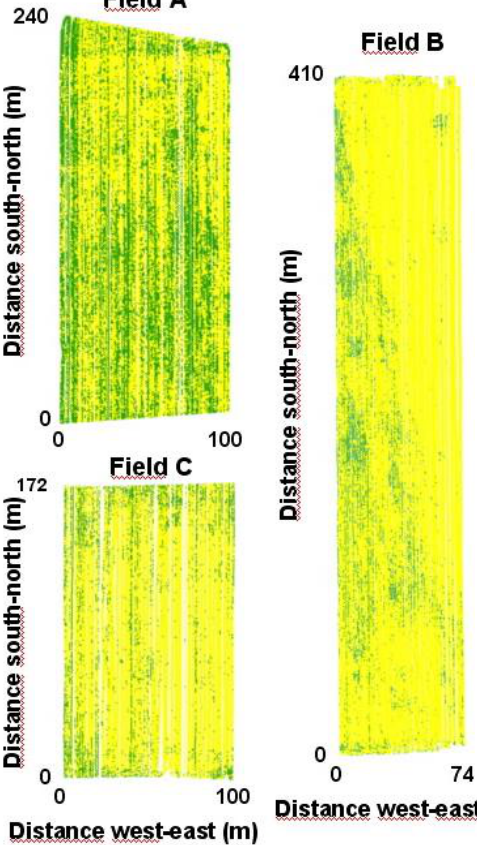
Figure 1. Detailed maps based upon weed sensing in all crop rows (sensors separated 0.75 m). Green points indicate presence of weeds, i.e. , weed coverage  15%. Yellow points indicate weed free areas, i.e. , <15% weed cover.